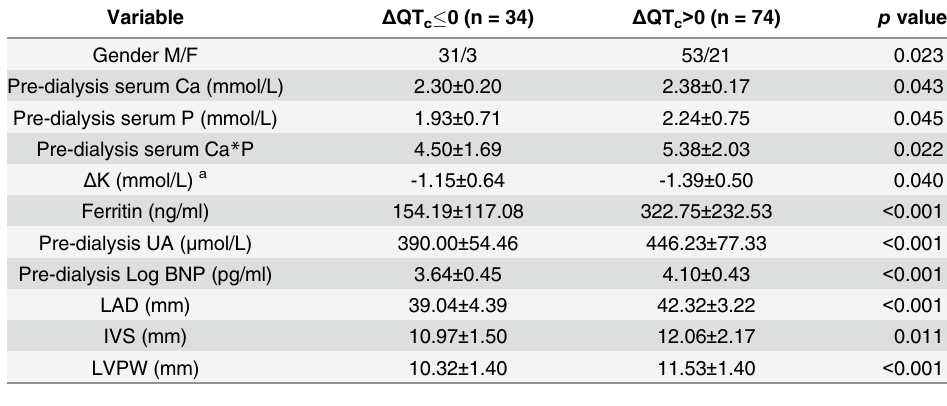
Table 5. Comparative analysis of variables according to the QT c change between pre-HD and peak stress (n =